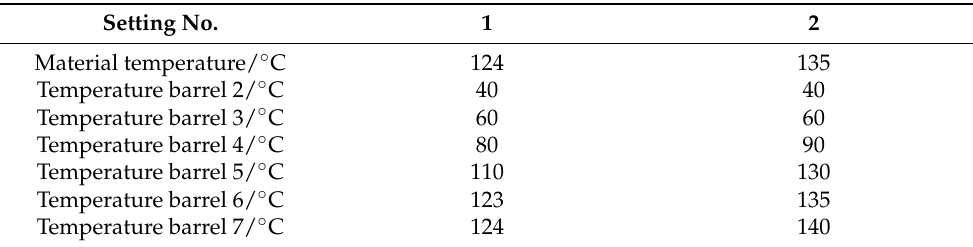
Table 1. Temperature profile of extruder barrel sections for the cases of a material temperature of 124 ◦ C and 135 ◦